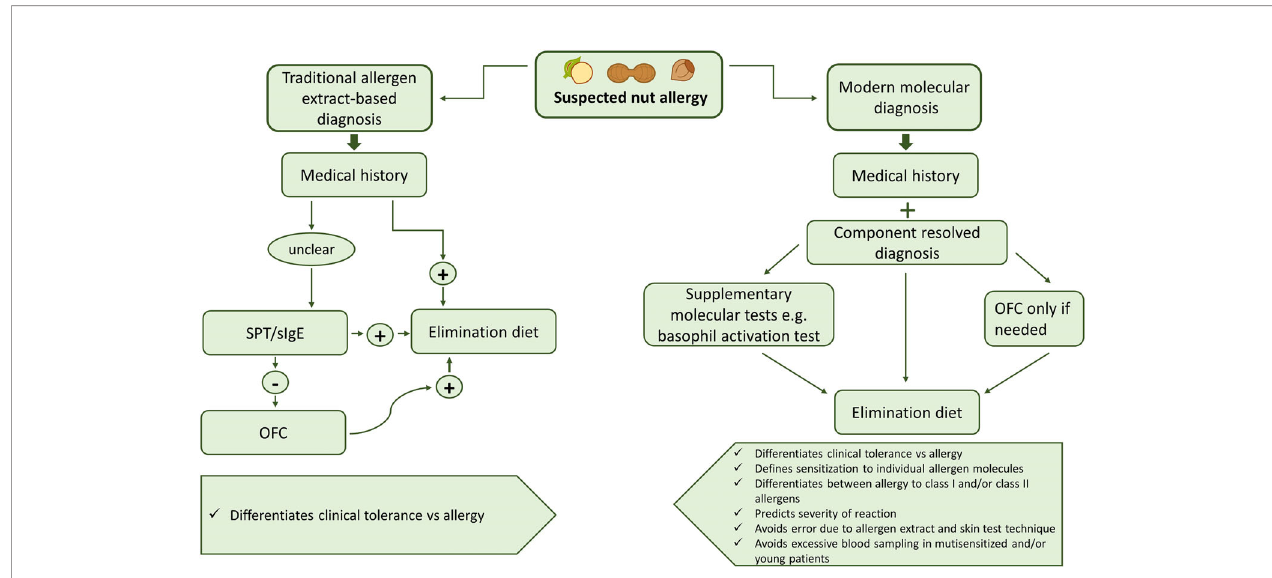
FIGURE 3 | Overview of traditional allergen extract-based nut allergy diagnosis in comparison with modern molecular